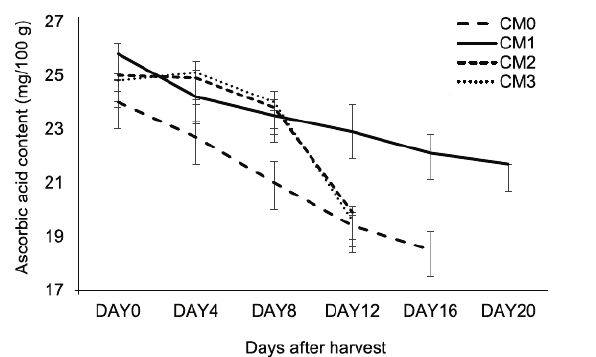
Fig. 5 ­ Effect of cactus mucilage coating on ascorbic acid con­ tent of bell pepper. Error bars indicate ±SE of the mean. CM0 is fruit coated with 0% cactus mucilage, CM1 is fruit coated with 1% cactus mucilage, CM2 is fruit coated with 2% cactus mucilage and CM3 is fruit coated with 3% cac­ tus